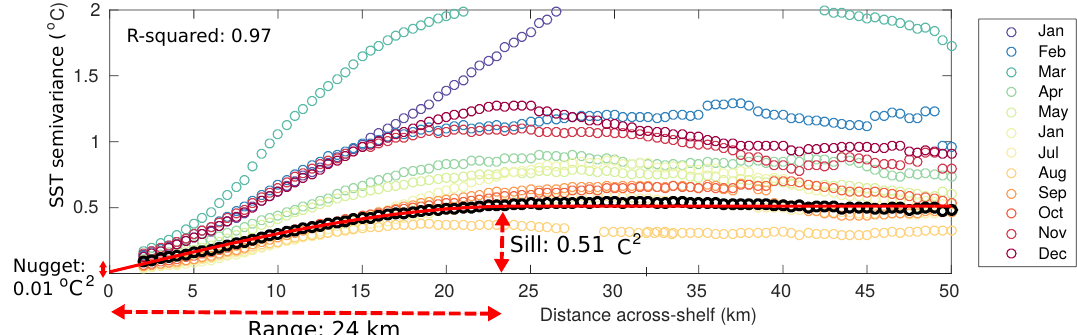
Figure 2. Cross-shelf empirical semivariogram estimated from daily SST over the southeastern Australian shelf (depth < 200m, 29–34 ◦ S, AVHRR L3S product) for 2014 (black bold dots) and for each month in 2014 (coloured dots). The spherical model (red line, R squared of 0.97 for the fit) and resulting parameters (range, sill, nugget) are shown for 2014